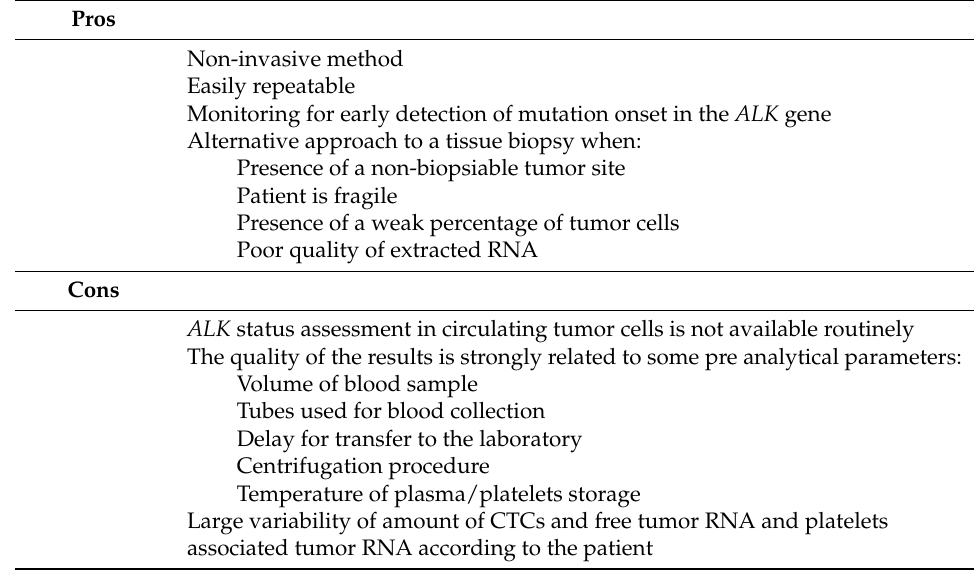
Table 1. The pros and the cons of anaplastic lymphoma kinase ( ALK ) gene analysis with a liquid biopsy in non small cell lung cancer